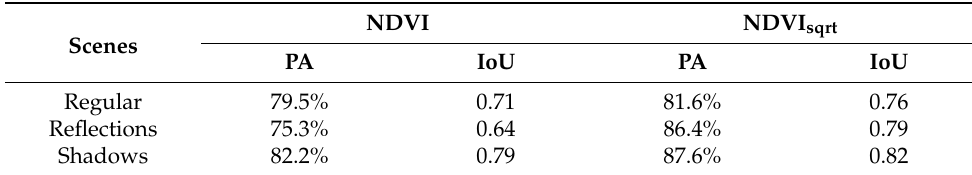
Table 2. Comparison of the detection performance of different feature-extraction methods for cyanobacterial blooms under various scenarios.